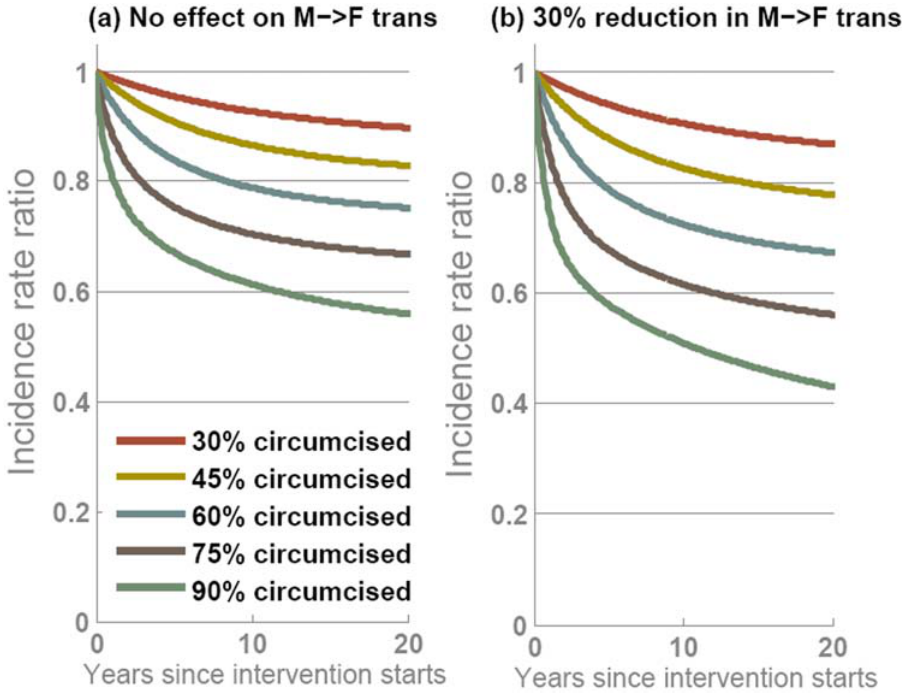
Figure 3. Projected impact of male circumcision interventions over time with different levels of coverage achieved if, (a) circumcised men are 60% less likely to get infected but there is no effect on male-to-female transmission; and, (b) circumcised men are 60% less likely to get infected and circumcised men are 30% less likely to transmit infection. In each panel, five epidemic projections show circumcision interventions with 30% (red line), 45% (yellow line), 60% (blue line), 75% (brown line) or 90% (green line) of men being circumcised. The output is the ratio of HIV incidence when the intervention is simulated relative to the projection with no intervention. Endemic HIV prevalence before the intervention is 23%.